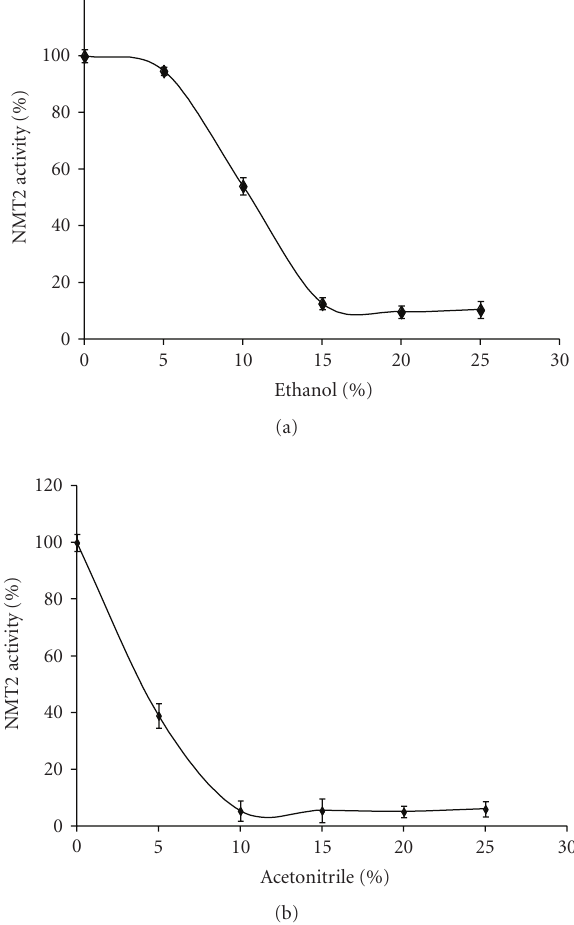
Figure 6: E ff ect of ethanol (a) and acetonitrile (b) on bovine brain NMT2. Bovine brain NMT2 (1.0 μ g/assay) activity was determined in the presence of carrying concentrations (0–25%) of ethanol and acetonitril using cAMP-dependent protein kinase derived peptide substrate (1.0 mM). The reactions were initiated by the addition of 0.27 μ M[ 3 H] myristoyl CoA and incubated at 30 ◦ C for 30 minutes. The data presented are representative of at least three separate